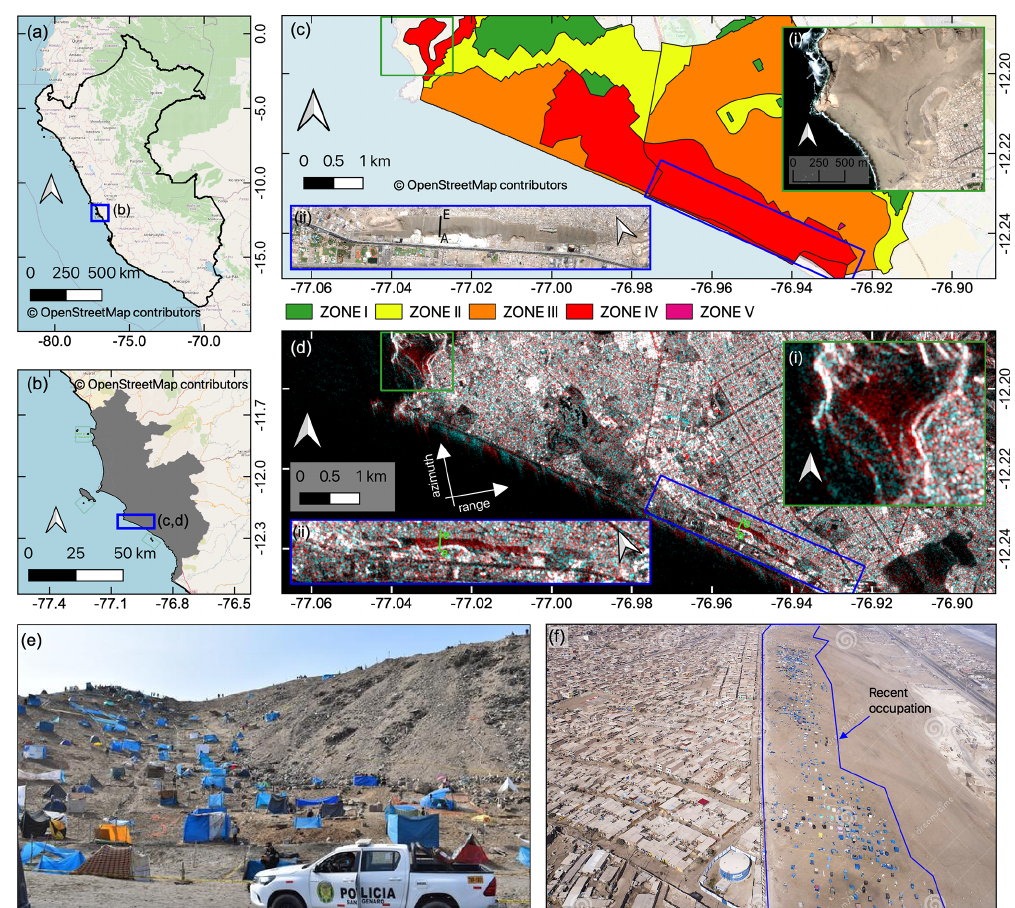
Figure 1. Location of the study area. (a) Location of metropolitan Lima (blue rectangle) within Peru. (b) Location of the study area (blue rectangle) within metropolitan Lima, which is partly located in the districts of Chorrillos and Villa el Salvador. (c) Seismic microzonation of the study area. The green rectangle denotes the location of inset (i), the Morro Solar. The blue rectangle denotes the location of the inset (ii), the Lomo de Corvina. Basemap of insets: MAXAR imagery. (d) Color composite of synthetic aperture radar (SAR) backscattering intensity images. Red band: image recorded on 14 April 2021; green and blue band: image recorded on 3 December 2020. (e) Photograph of the squatter settlement in the Morro Solar recorded by Gestion (2021). (f) Photograph of the squatter settlement in Lomo de Corvina (modified from Inga,